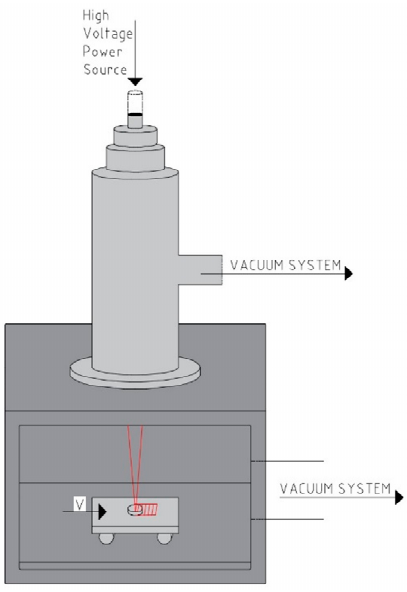
Figure 1. A scheme of electron-beam equipment for surface modification.